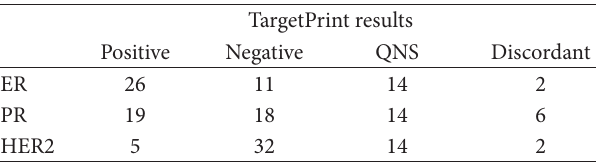
T 2: Summary of TargetPrint receptor